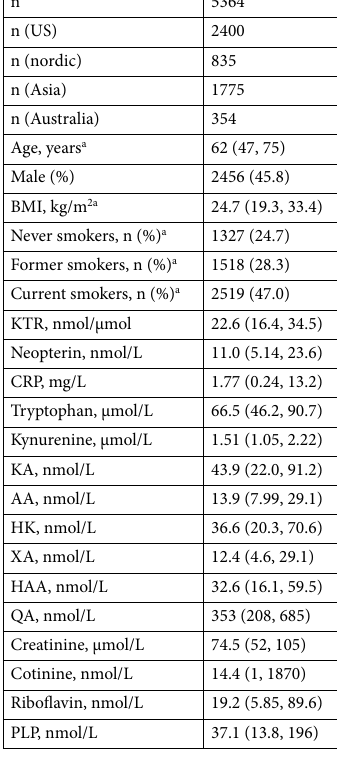
Table 1. Characteristics of participants. Values are median (95% CI) or n (%). AA: anthranilic acid; BMI: body mass index; CRP: C-reactive protein; HAA: 3-hydroxyanthranilic acid; HK: 3-hydroxykynurenine; KA: kynurenic acid; KTR: kynurenine/tryptophan; PLP: pyridoxal 5 ′ -phosphate; QA: quinolinic acid; XA: xanthurenic acid. a Age, BMI and self-reported smoking status at date of blood